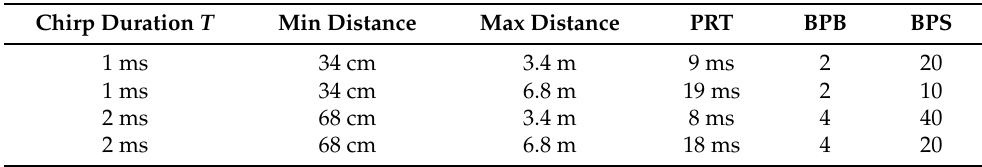
Table 2. Four possible configurations of DFCE system parameters. Chirp Duration T Min Distance